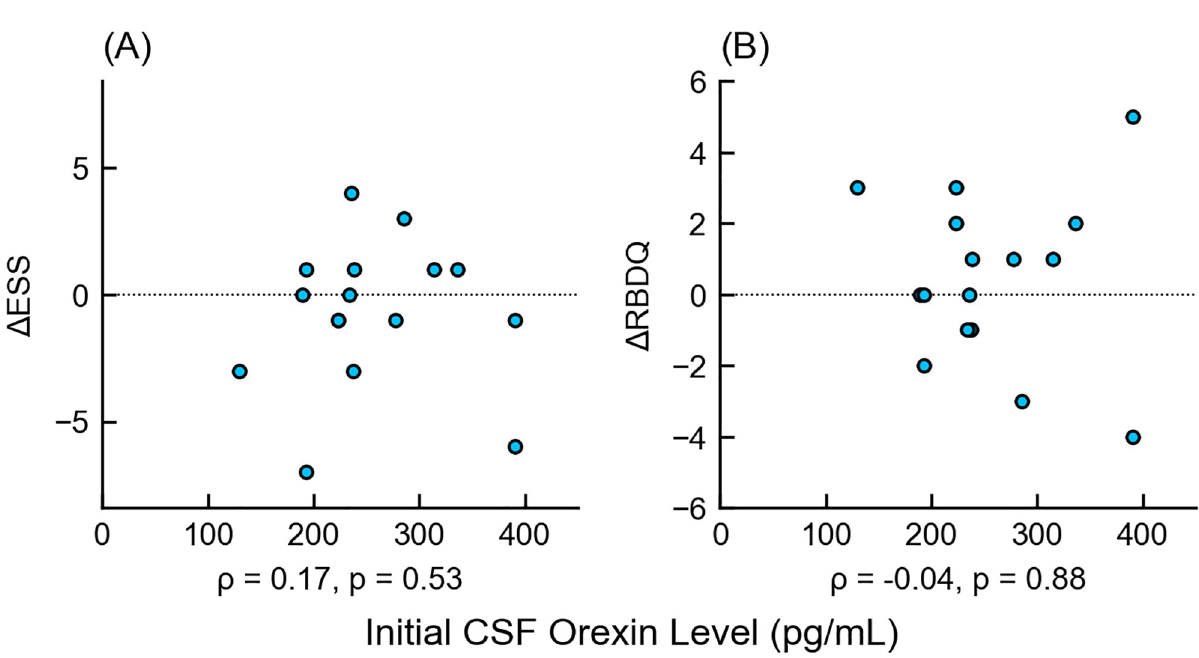
Fig 6. Scatter plot of initial cerebrospinal fluid orexin levels and longitudinal changes in main clinical characteristics. The x-axis shows the initial CSF orexin levels, and the y-axis shows the increase in (A) ESS or (B) RBDQ from the initial examination. There was no correlation between the initial CSF orexin levels and the increase in clinical scores. Δ -, increment of -; ESS, Epworth Sleepiness Scale; RBDQ, Rapid Eye Movement Behavior Disorder Questionnaire.